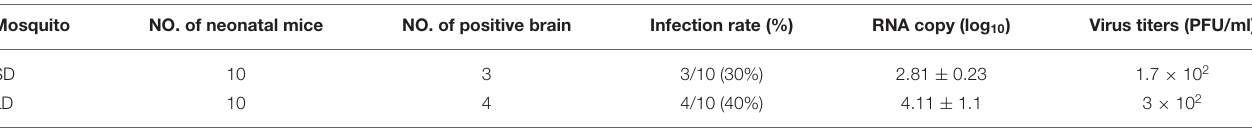
TABLE 2 | Detection for ZIKV RNA of the brain after F1 offspring females of the second gonotrophic cycle bit neonatal mice. Mosquito NO. of neonatal mice NO. of positive brain Infection rate (%) RNA copy (log 10 ) Virus titers (PFU/ml) SD 10 3 3/10 (30%) 2.81 ± 0.23 1.7 × 10 2 LD 10 4 4/10 (40%) 4.11 ± 1.1 3 × 10